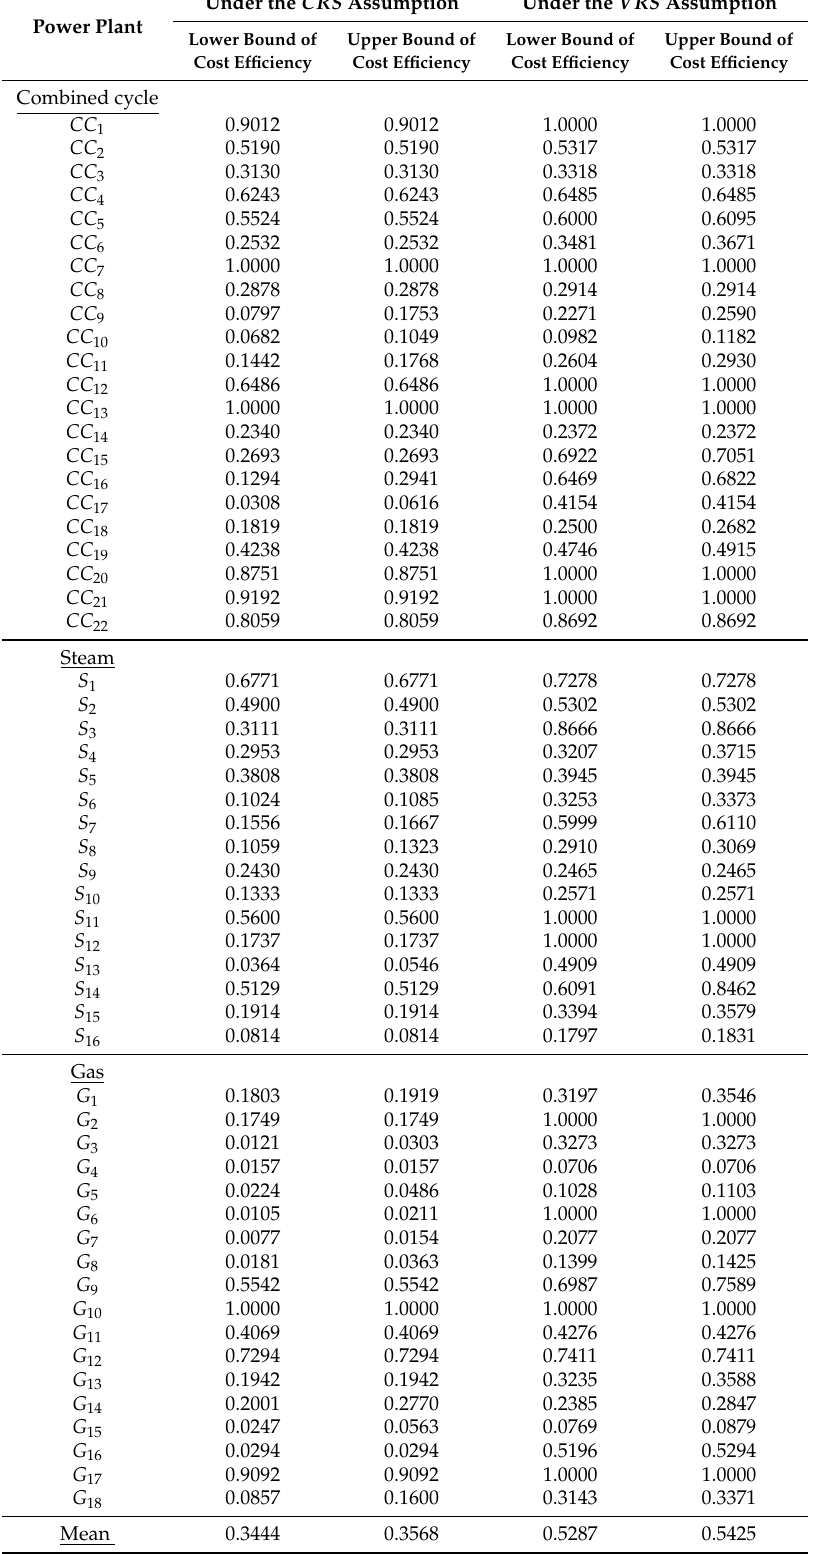
Table 2. Results obtained from the evaluation of the lower and upper bounds of the cost efficiencies of the power plants selected in 2015 under constant returns to scale ( CRS ) and VRS with the semi-disposability